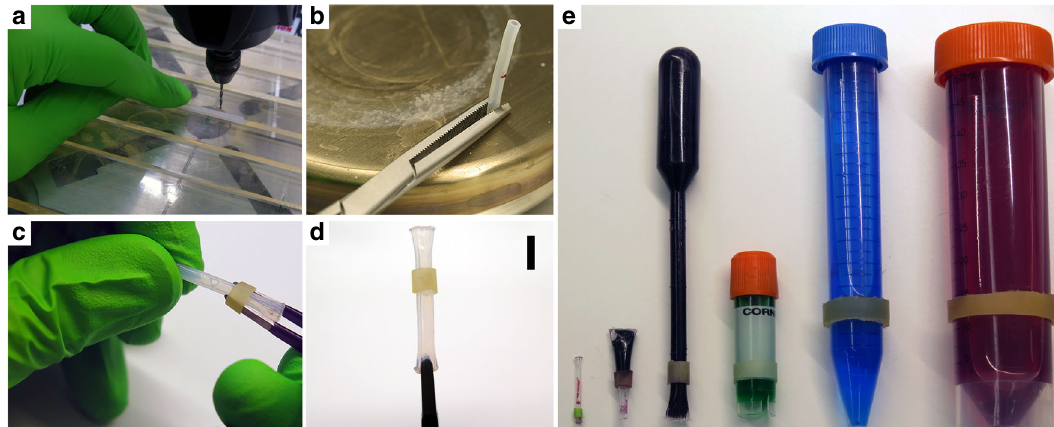
Fig. 7 Scalability and procedure of producing a cylindrical micro-dispenser. a Drilling the outlet aperture on a prede fi ned length of an impermeable tube, b sealing each side of the tube, c sheathe in a prede fi ned length of an elastic membrane, d close-up view of a micro-dispenser, the scale bar is 500 μ m, e examples of scalability of micro-dispensers the micro-dispenser is autoclaved and packed, if necessary. Before use, the reagent components required for fabricating the device, i.e., an impermeable tube and a fl exible membrane with low permeability and preferably high elasticity. The tube is is dispensed into the tube and the membrane is pulled to now completely cover the aperture. Note that, the micro-dispenser can be fi lled using a syringe or an measured, cut, and a drill is used to pierce one or multiple apertures. Both sides of Eppendorf micro-loader depending on the micro-dispenser dimensions. All com- the tube are sealed using a clamp and a hot plate. The tube is sheathed in the ponents of the micro-dispenser are purchased from well-known suppliers that membrane, which was previously measured and cut by a sharp scalpel, using a allow for estimating the fabrication cost of prototype micro-dispensers. Depending three-pronged plier. At this point, the membrane is half-covering the aperture and